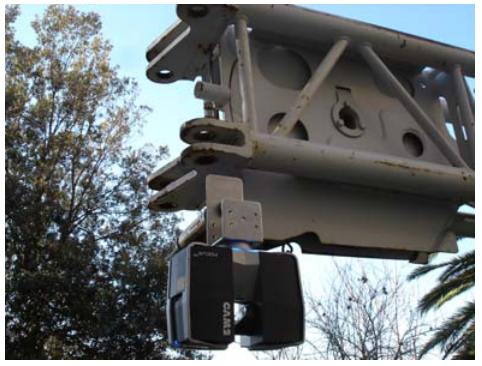
Fig. 12: Laser scanner on the crane boom